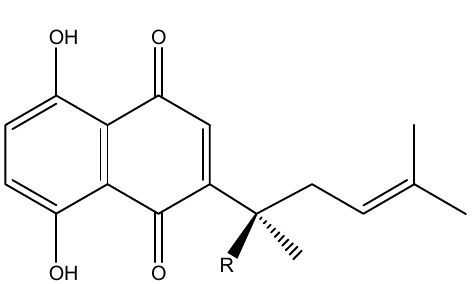
Figure 1. Structure of